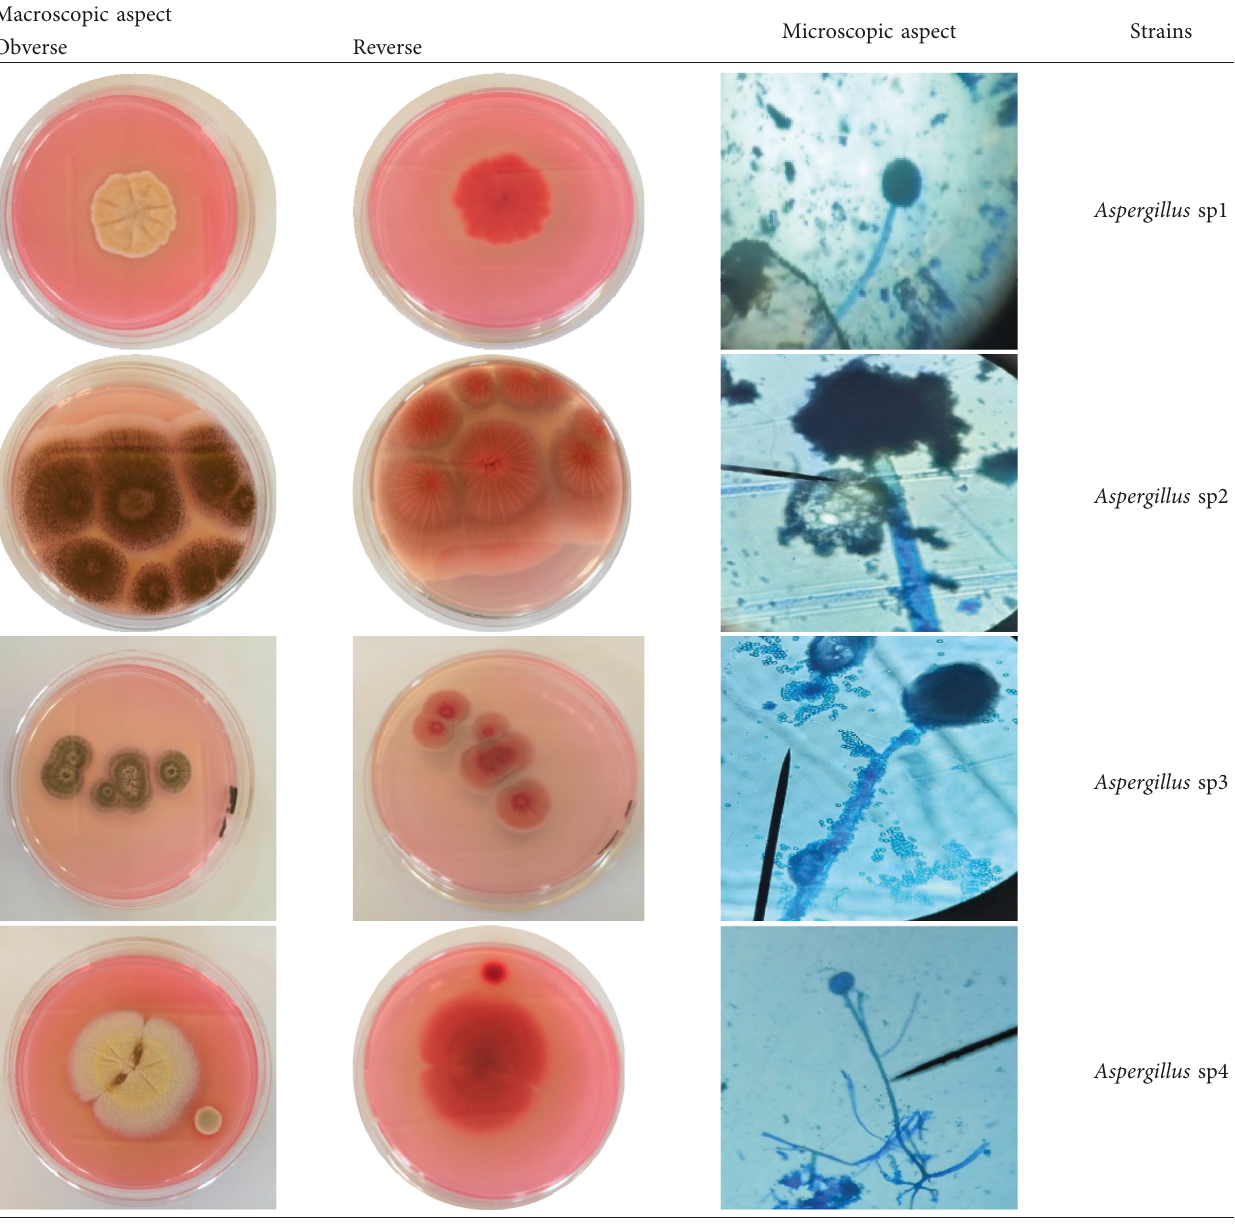
Table 2: Macroscopic and microscopic aspect of mould